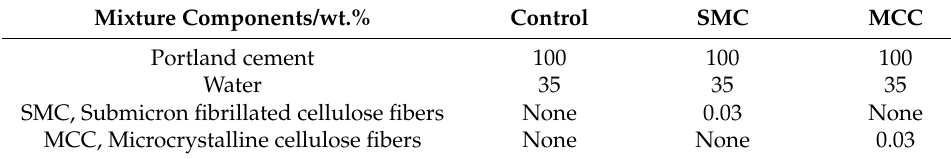
Table 2. Cement pastes produced.